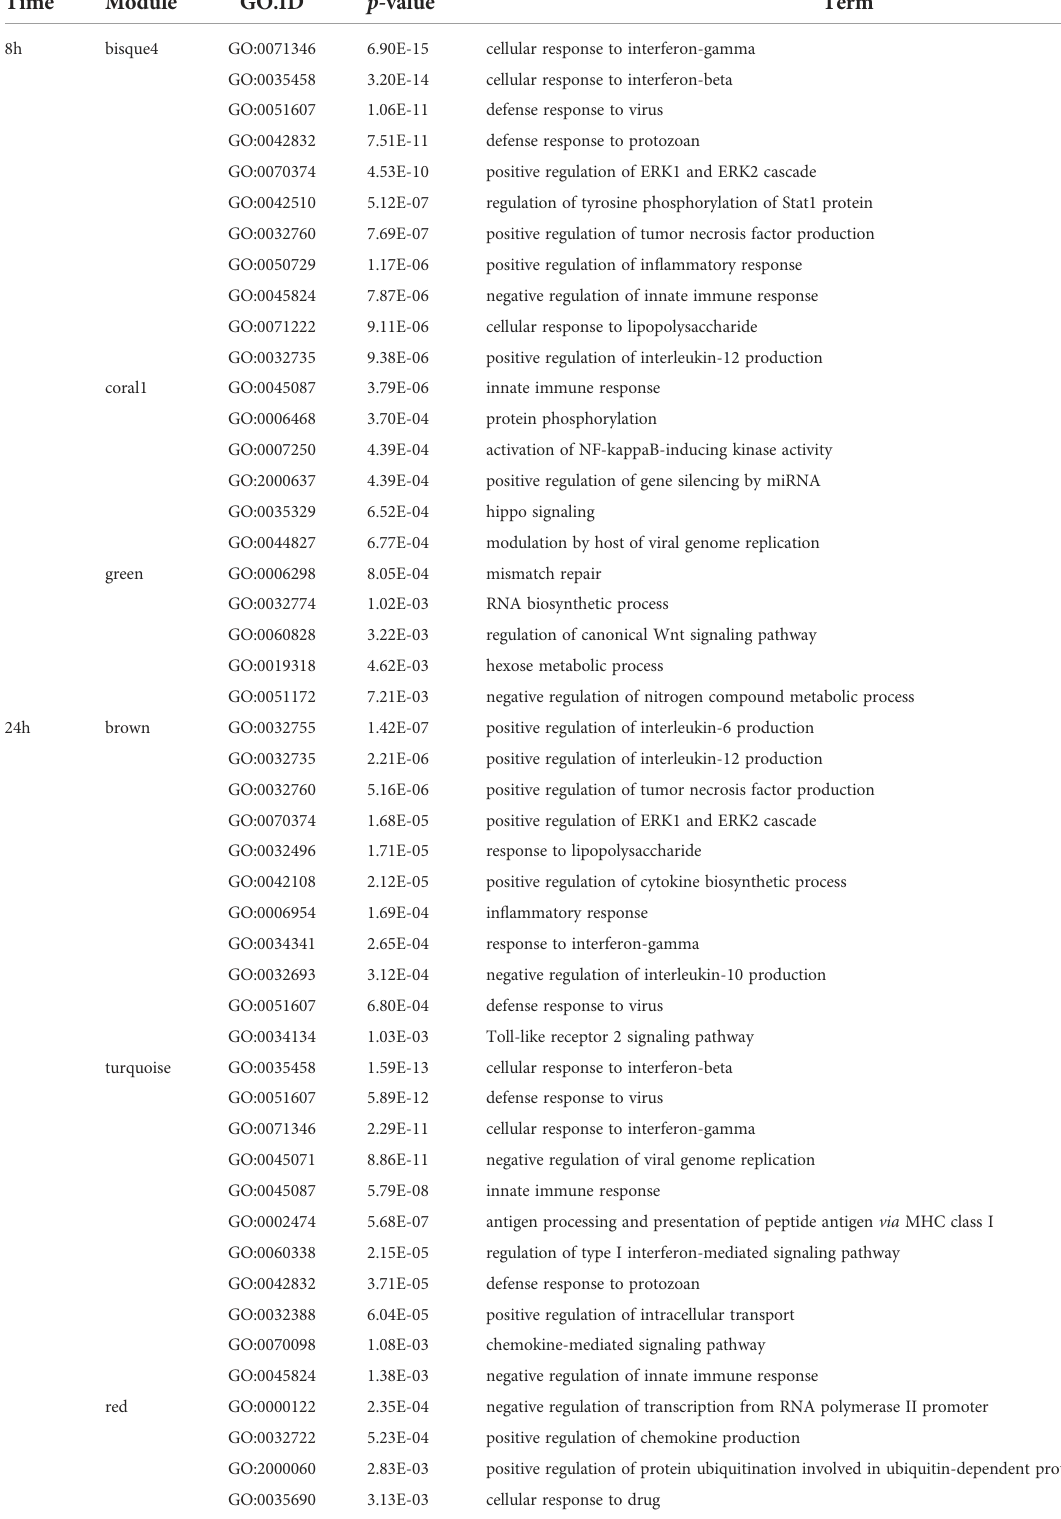
TABLE 3 Examples of main Gene Ontology (GO) terms of tip modules in WT analysis (biological process “ BP ” category and p -value < 0.01) at 8 and 24 h p.i. Time Module GO.ID p -value Term